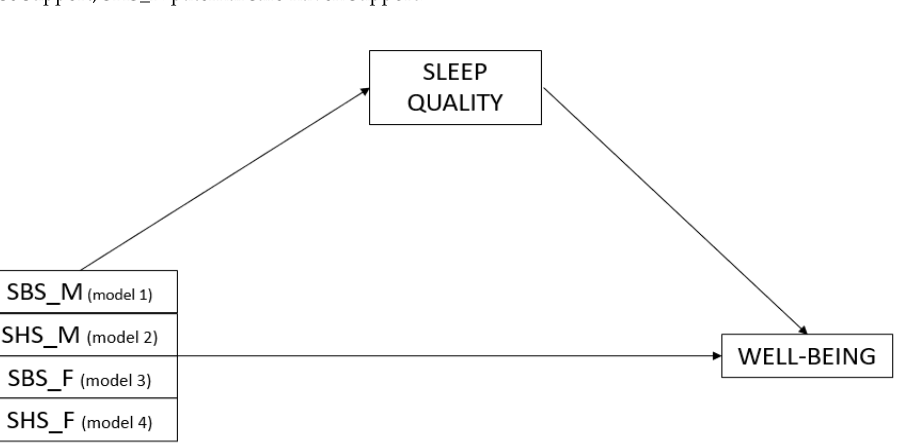
Figure 1. Representation of the four mediation models with the designations of the variables; SBS_M: secure base support (mother); SHS_M safe haven support (mother); SBS_F: secure base sup- port (father); SHS_F safe haven support (mother) .